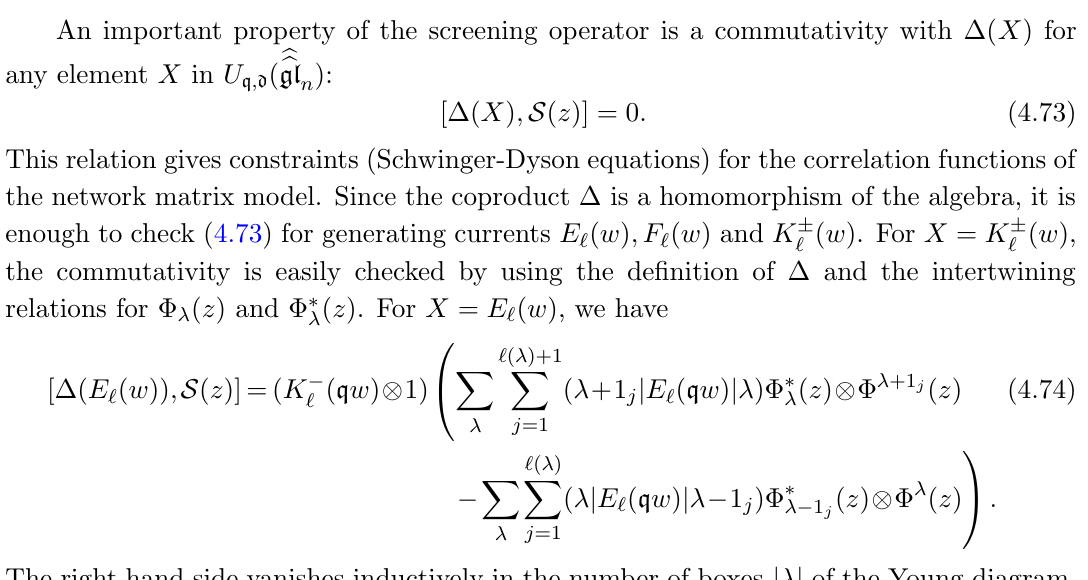
Figure 3 . Gluing two intertwiners (cid:8) and (cid:8) (cid:3) gives the T -operator (horizontal gluing) or the screening operator (vertical